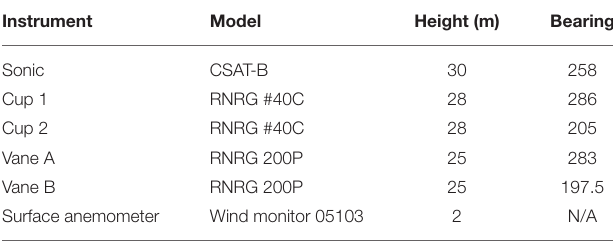
TABLE 1 | Overview of the anemometry at the One Energy Science Park.